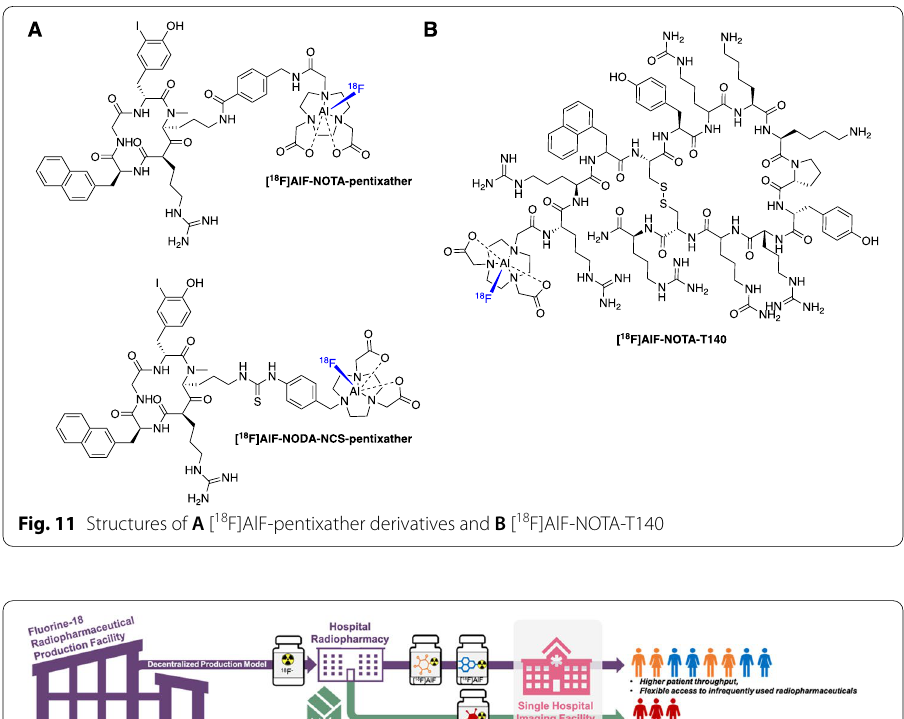
Fig. 12 Whether [ 18 F]AlF radiopharmaceuticals are produced in a decentralised radiopharmacy using kit-based procedures alongside 68 Ga-radiopharmaceuticals, or a centralised fluorine-18 radiopharmaceutical production facility will depend on radiopharmaceutical demand and